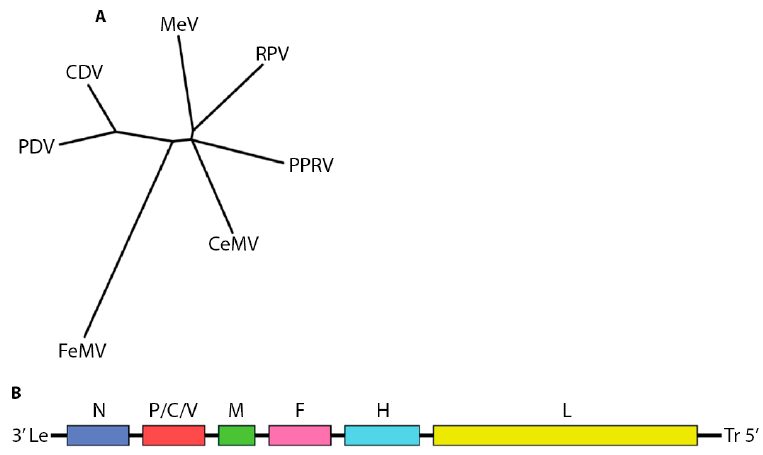
Figure 1. Overview of the morbillivirus genus. ( A ) Phylogenetic analysis of amino acid sequences of nucleocapsid genes of different morbillivirus reference strains. The unrooted tree was constructed using the neighbor ‐ joining method. Branch lengths are relative and proportional to the number of substitutions. The unit of branch length is the number of substitutions (excluding gaps) at each given nucleotide position. Alignments were made with ClustalW2 [2–4] and trees rendered with Drawtree from the PHYLIP package 3.67 [5,6]. Genbank accession IDs: FeMV JQ411014; MeV NC_001498; PDV P35944; PPRV NC_006383; CeMV NC_005283; CDV NC_001921; RPV YP_087120.2); ( B ) Cartoon of morbillivirus genome